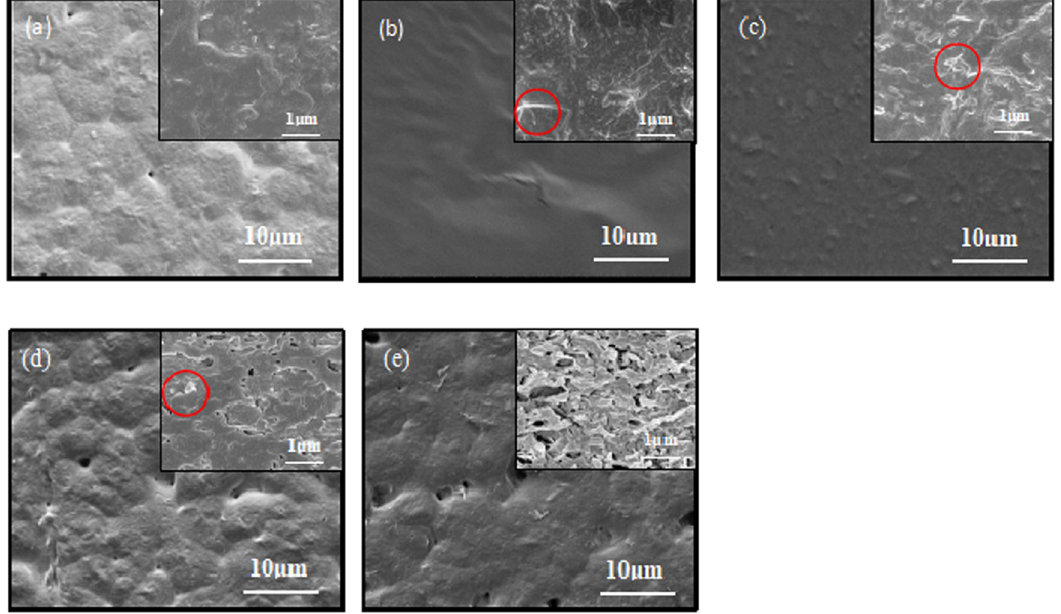
Figure 2: Scanning electron microscopy images of the surface and cross - section of PHBH and MMT/PHBH biocomposites: ( a ) PHBH, ( b ) 1 wt% MMT/PHBH, ( c ) 3 wt% MMT/PHBH, ( d ) 5 wt% MMT/PHBH, and ( e ) 7 wt%